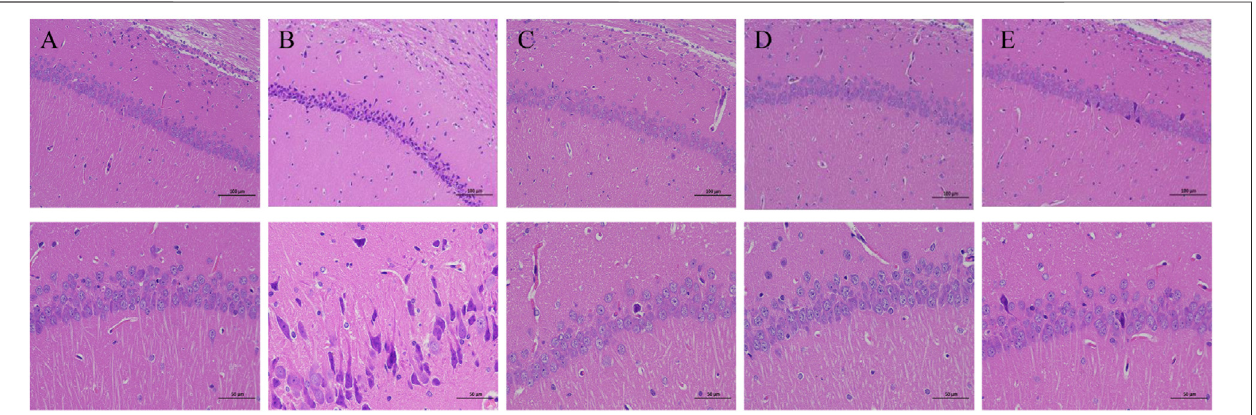
Frontiers in Pharmacology |